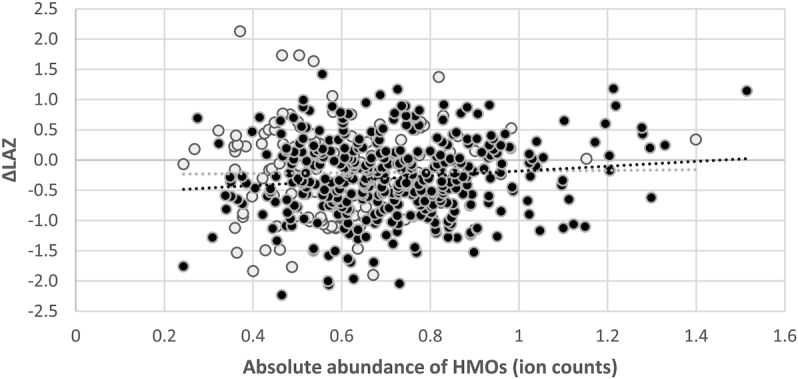
Association of change in infant length-for-age z-score (LAZ) from 6 to 12 mo with absolute abundance of human milk oligosaccharides (HMOs) in women with the secretor phenotype in black (n = 485) and nonsecretor phenotype in gray (n = 162). Among secretors, a one-tenth of 1 unit increase in absolute abundance of HMOs (∼15% increase in the median value) would correspond with a 0.04 (95% CI: 0.003, 0.077) unit increase in the change in LAZ from 6 to 12 mo (P = 0.035, assessed by covariate-adjusted linear regression). There was no significant association in nonsecretors (P = 0.889).